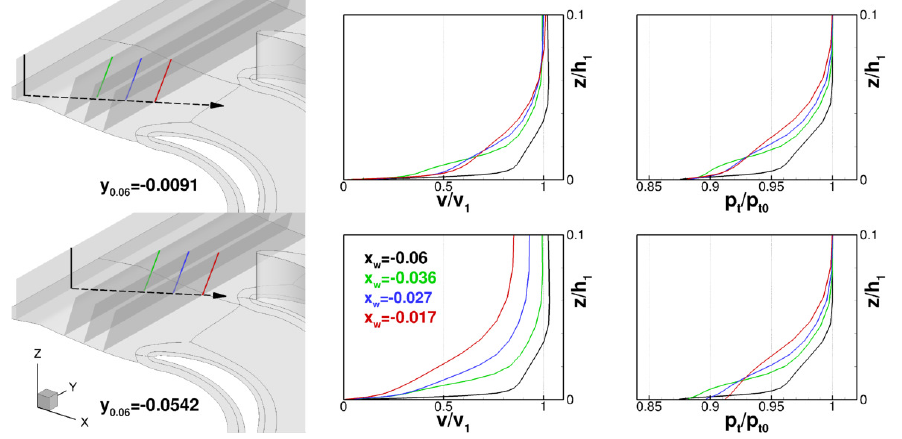
Figure 4. Boundary layer development on the divergent endwall at two pitchwise